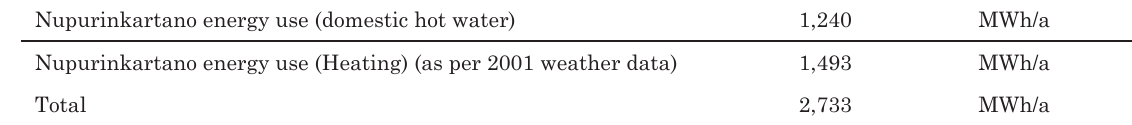
emission factors 2